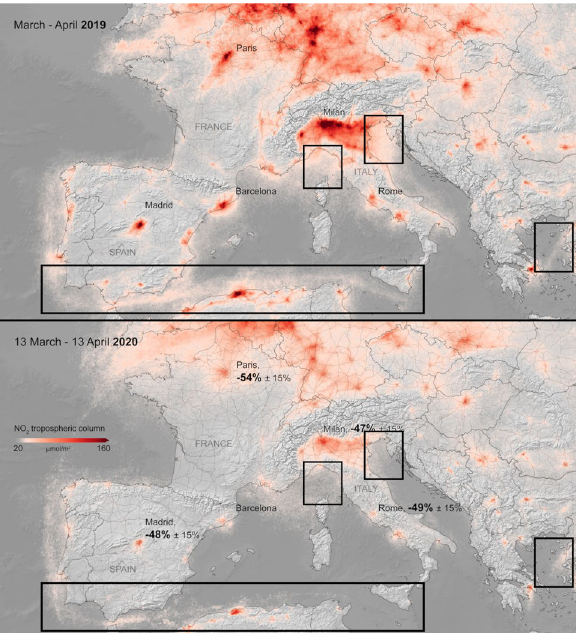
Figure 2. Average nitrogen dioxide (NO 2 ) concentrations from 13 March to 13 April 2020, compared to the same period in 2019. The decrease of emission is evident, around −50% in large European cities (Rome, Paris, Madrid and Milan). Highlighted with boxes there are regions of sea where it is evident a decrease of nitrogen dioxide concentrations, probably due to the reduced shipping activity. WHO air quality guideline values − 3 quantify in 40 µ g m (annual mean) the NO 2 limit level for human health 12 . Reproduced with permission. © Contains modified Copernicus Sentinel data (2019–2020), processed by KNMI/ESA 13